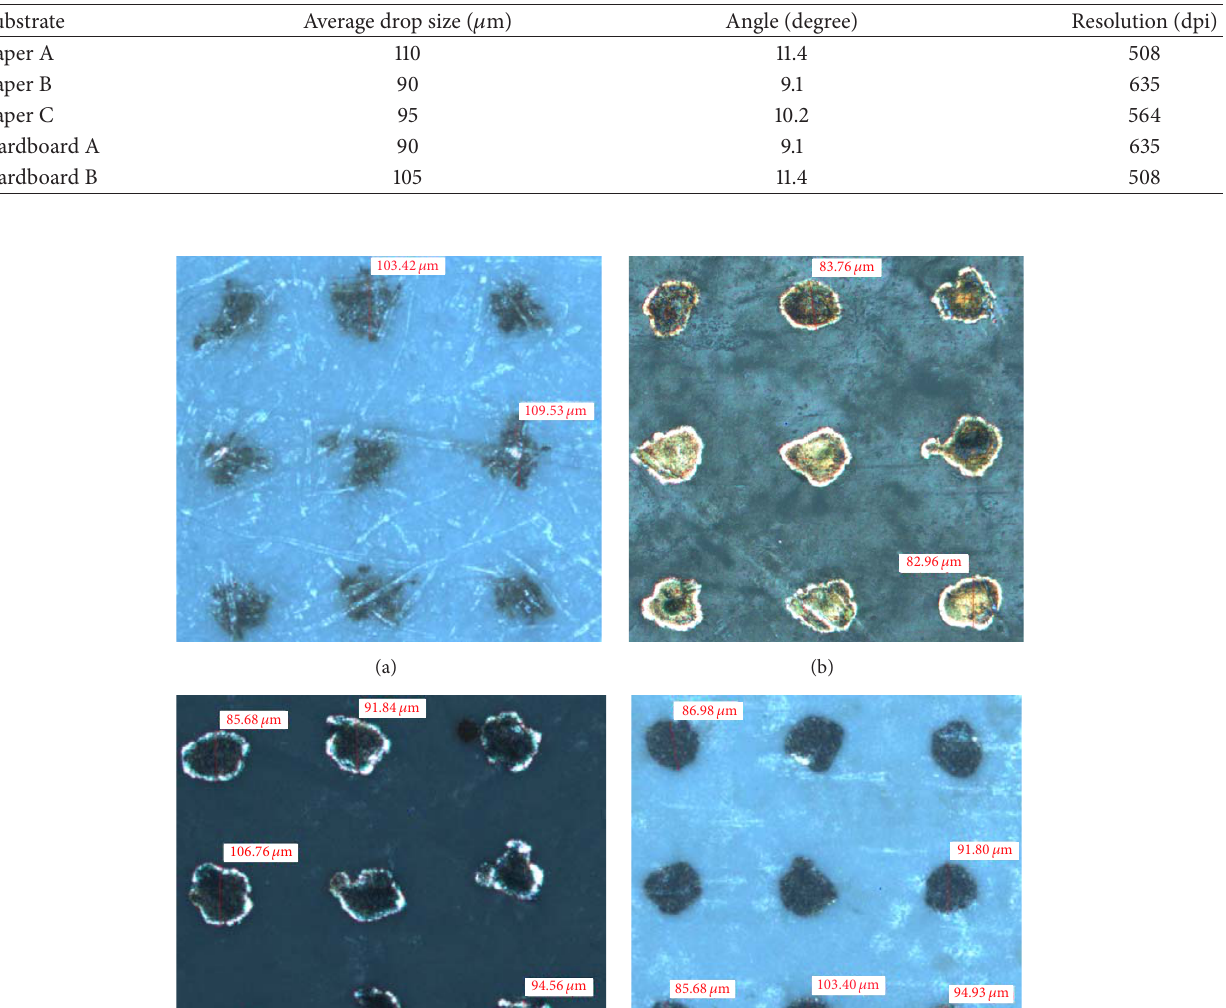
Table 3: Printing resolution of every substrate.